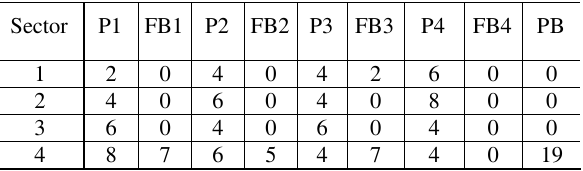
Table 3. Numerical data modified according to Goldratt’s